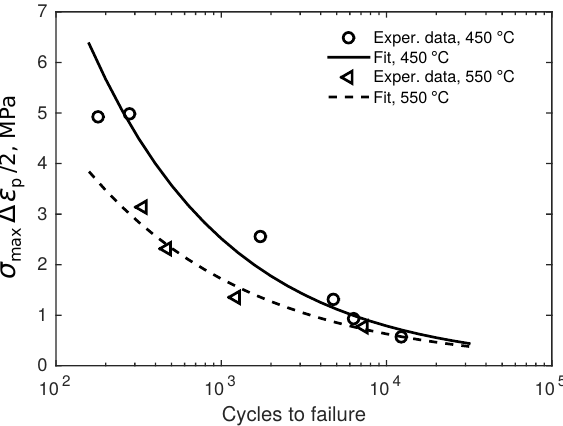
Figure 3. Fatigue life model calibration for smooth specimens at 450 °C and 550 °C. Fatigue life is de- scribed in terms of the modified SWT parameter, σ max ∆ ε p / 2.